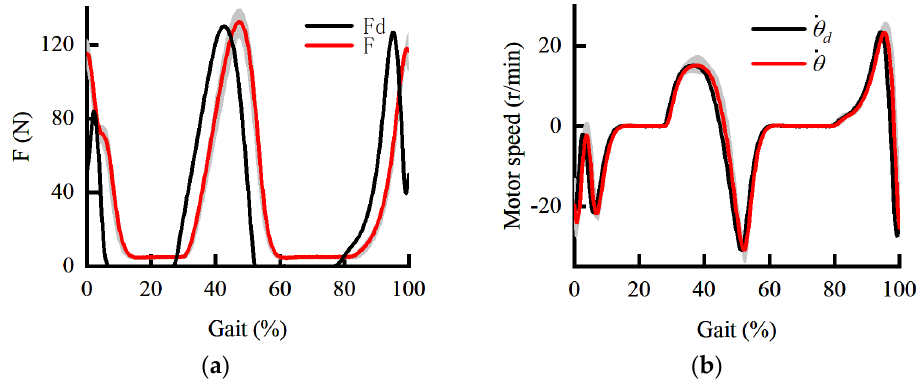
Figure 9. The dynamic curve under PID control. ( a ) The dynamic curve of force response; ( b ) the dynamic curve of speed response.